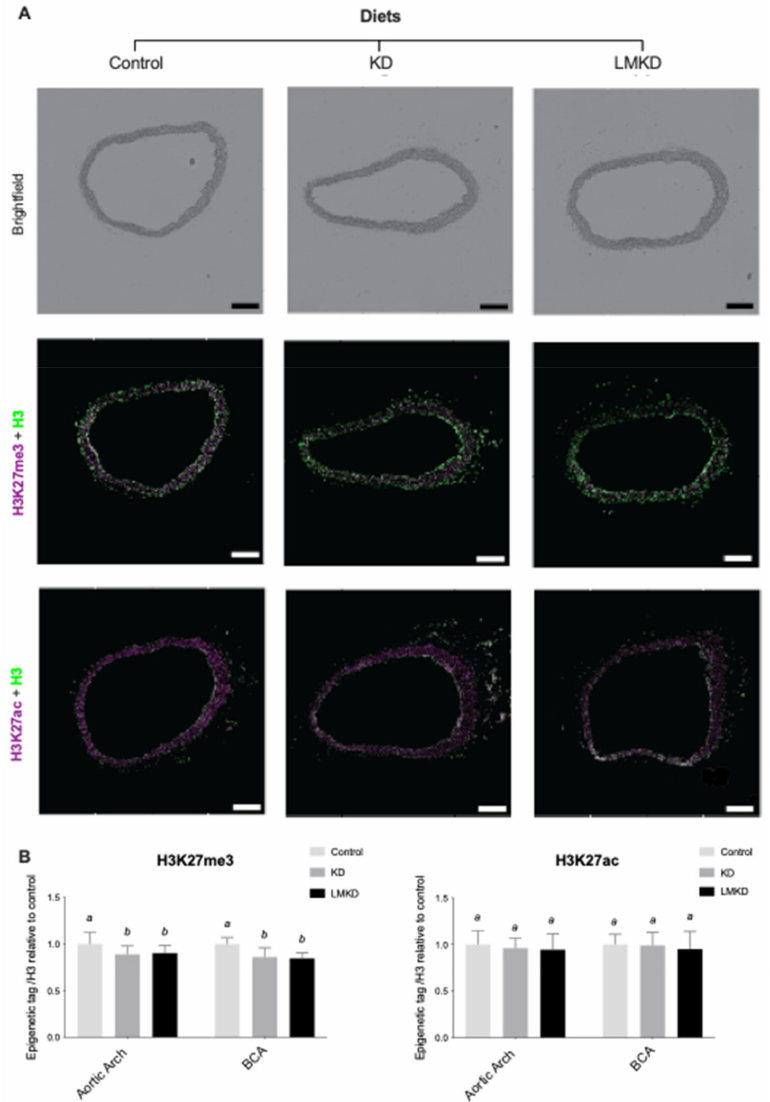
Figure 5. The effect of the experimental diets (ketogenic diet, KD; low methyl ketogenic diet, LMKD; and control) on the vascular content of specific epigenetic tags at lysine 27 on histone H3 (H2K27me3, tri-methylation; H3K27ac, acetylation) in the aortic arch and brachiocephalic artery (BCA). ( A ) Representative images of brightfield and immunofluorescence quantification of BCA cross sections. Total histone 3 (H3) in green, and histone 3 trimethylation at lysine 27 (H3K27me3) or acetylation (H3K27ac) in magenta. Scale bars = 200 µ m. ( B ) Immunohistochemistry results. Data are the mean ± SD, n = 35. Bars bearing different letters were significantly different ( p <